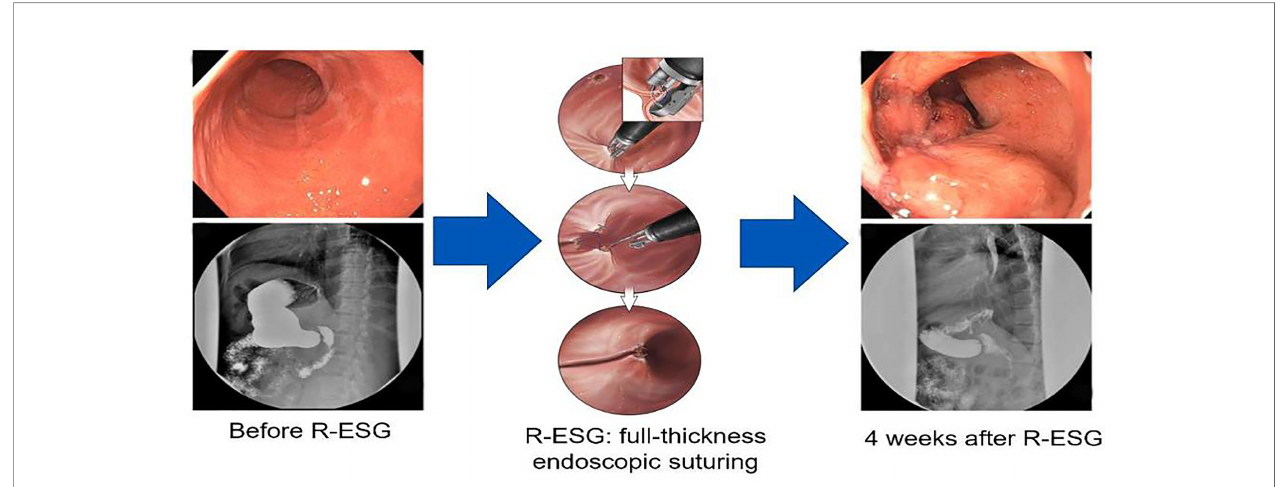
FIGURE 3 | Endoscopic sleeve gastroplasty for endoscopic revision of sleeve